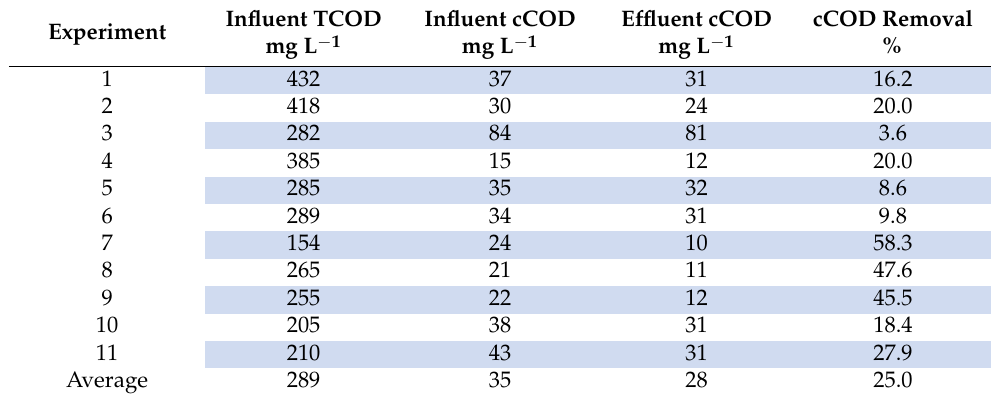
Table 2. Influent and Effluent cCOD Concentrations from 11 Biosorption Experiments with 30 min Contact